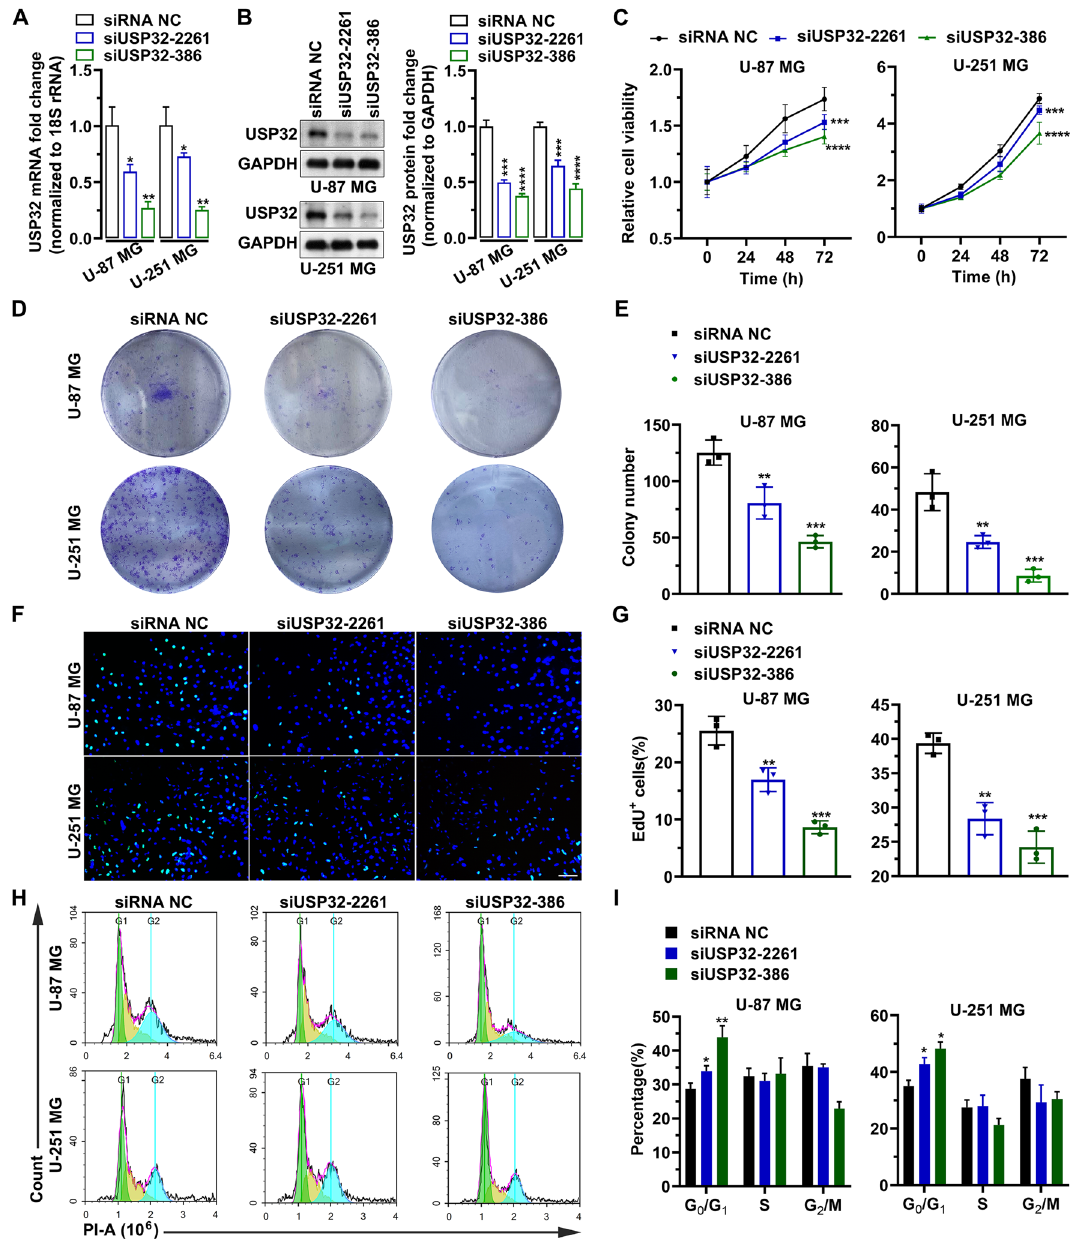
Figure 3. Knockdown of USP32 inhibits cell growth. ( A ) The mRNA level of USP32 was reduced by siUSP32- 2261 and siUSP32-386. Data are represented as mean ± SD of three biological replicates. ( B ) Left panel: Representative images of three independent western bolting analyses showing the knockdown efficiency of siUSP32-2261 and siUSP32-386. Right panel: statistical quantification of left panel. ( C ) MTT assay determining the cell viability of U-87 MG and U-251 MG. Data are represented as mean ± SD of six biological replicates. ( D ) Representative images of three independent colony formation assays showing that USP32 knockdown inhibited cell proliferation. ( E ) Statistical quantification of ( D ). ( F ) USP32 knockdown reduced the number of EdU + cells. Bar: 10 μm. ( G ) Statistical quantification of ( F ). Data are represented as mean ± SD of three technical replicates. ( H ) Representative images of three independent cell cycle assays by flow cytometry. ( I ) Histogram showing the percentage of each cell-cycle phase in ( H ). One way ANOVA followed by Tukey’s post-hoc test: vs siRNA NC, * p < 0.05, ** p < 0.01, *** p < 0.001, **** p <